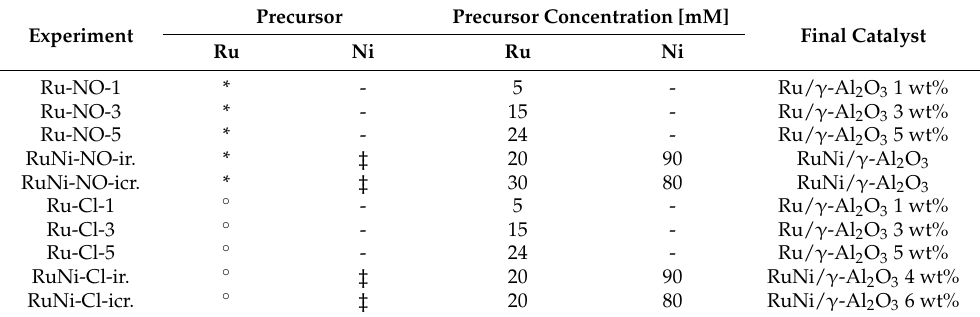
Table 1. Listing of the synthesised catalysts and the varied synthesis